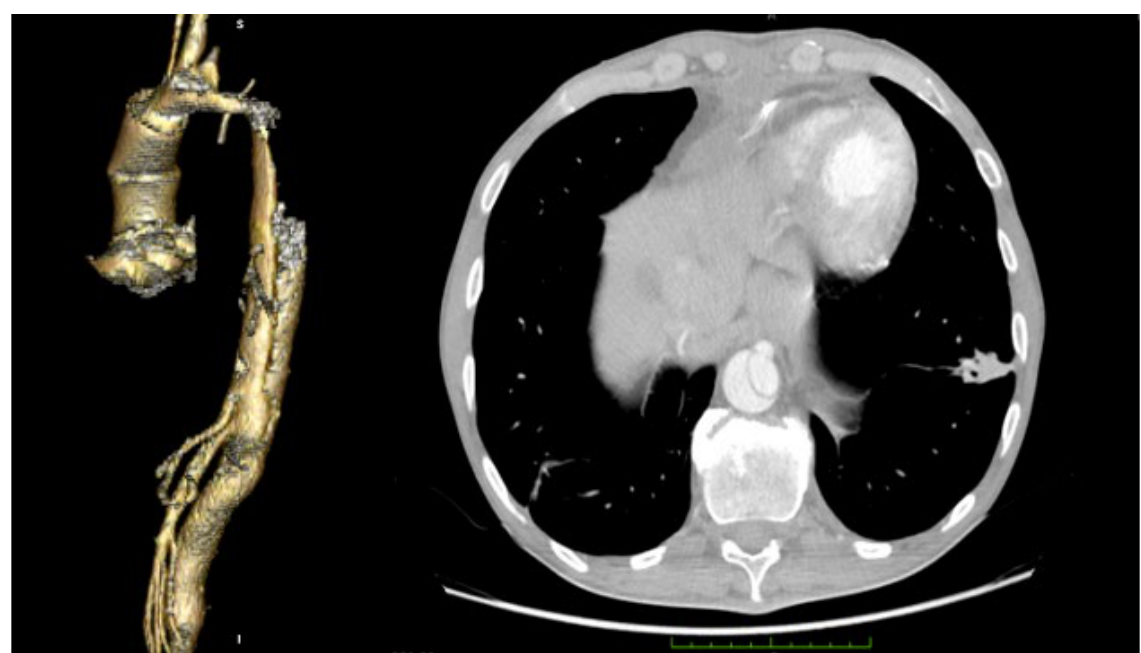
Figure 5. Small true lumen of the abdominal aorta at the origin of the celiac trunk, and protruding false lumen with a “double” intimal flap at this level.